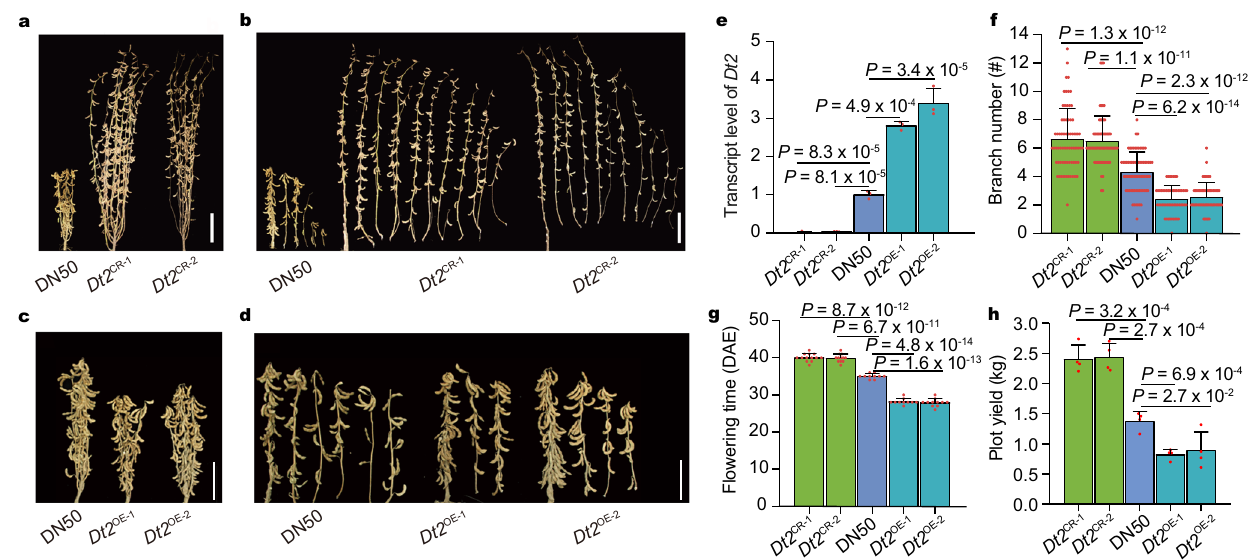
g Flowering time of DN50, Dt2 CR and Dt2 OE lines ( n =30 biologically independent plants). DAE indicates days after emergence. h Plot yield of DN50, Dt2 CR and Dt2 OE ( n =4 biologically independent replicates). The plot area is 10m 2 . Scale bars in the ( a – d ) are 10cm. Data in ( e – h ) are the mean±SEM. Statistical signi fi cance is determinedusingatwo-sided t -test.SourcedataareprovidedasaSourceData fi